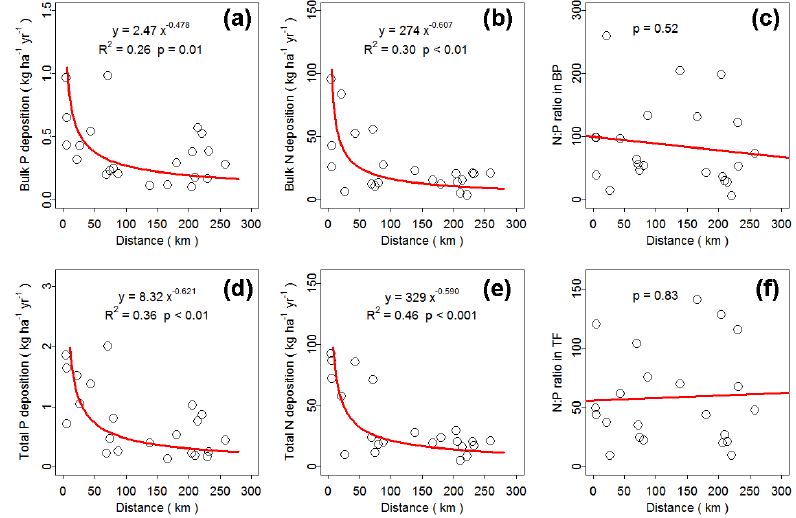
Figure 4. Changes in bulk deposition of P and N (kgha − 1 yr − 1 ) , total deposition of P and N (kgha − 1 yr − 1 ) , and N:P ratios in bulk precipitation (BP) and throughfall (TF), with the distance to the nearest large cities based on datasets of forested sites far from semiarid regions in